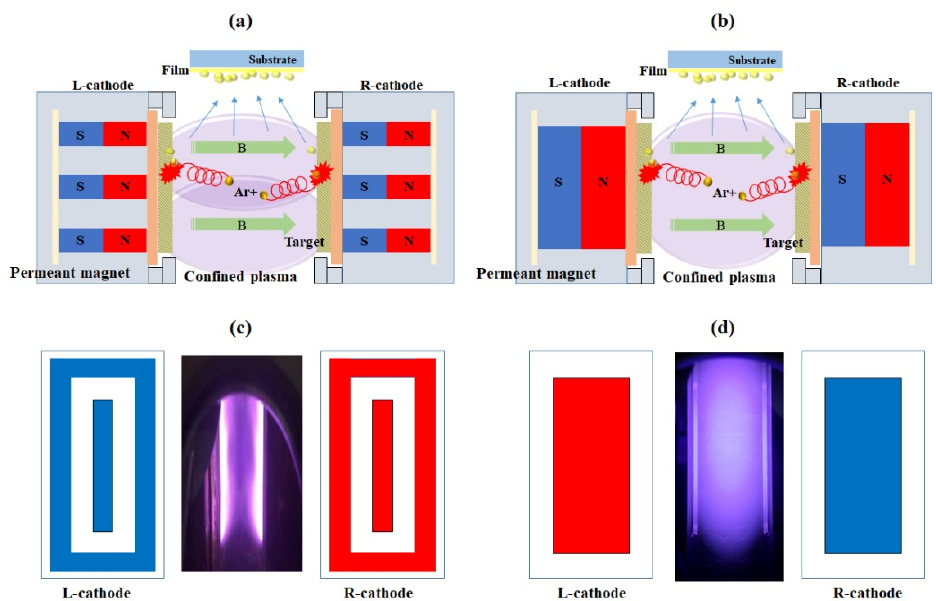
Figure 9. Schematic of the facing target sputtering system with various magnet arrays: ( a , c ) Open- type FTS, ( b , d ) Closed-type FTS, and plasma confined between targets for low-temperature sputtering. Reproduced with permission from ref. [29].